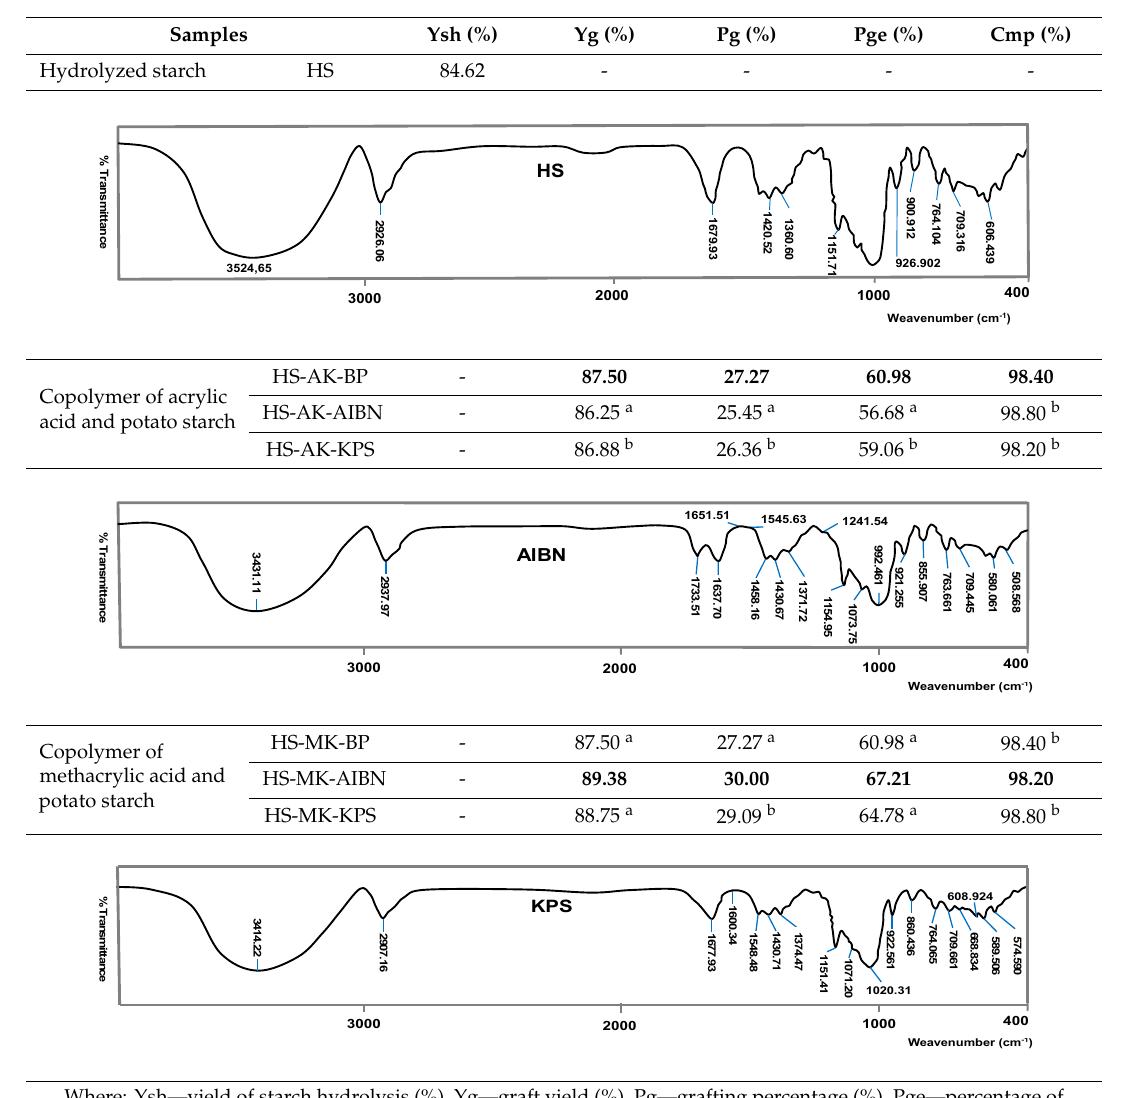
Table 3. FTIR spectra of the hydrolyzed and grafted starch per individual